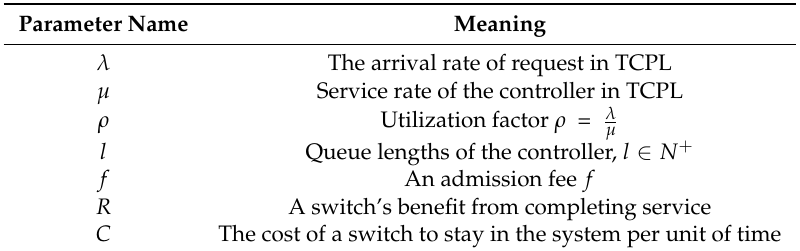
Table 1. Specifications of the parameters of TCQG